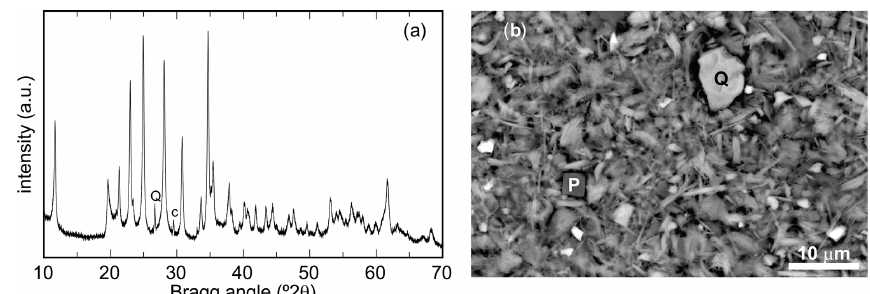
Figure 3. (a) Powder X-ray diffraction pattern of the chapmanite sample after the first treatment step. All peaks belong to chapmanite, with the exception of two small peaks that are assigned to quartz (Q) and calcite (C). (b) Secondary-electron image of this chapmanite sample, showing the small book-like aggregates of chapmanite but also small fragments of quartz (Q) and pseudomorphs of iron oxides after pyrite (P) with the cubic morphology.